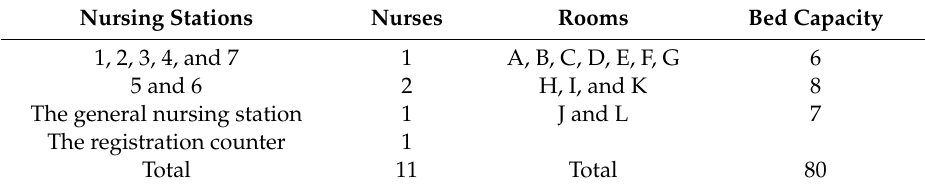
Figure 3. The floor plan of the outpatient chemotherapy area in the cancer medical center. Table 1. The allocation of nurses and beds in the ward area.